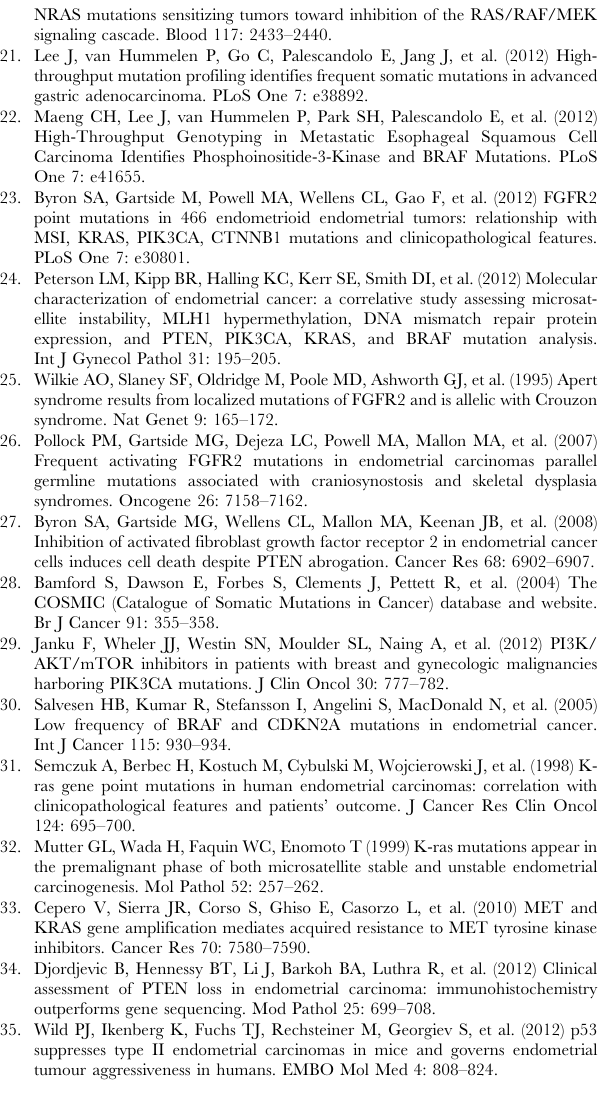
Table S1 Oncogene mutations and nucleotide changes included in